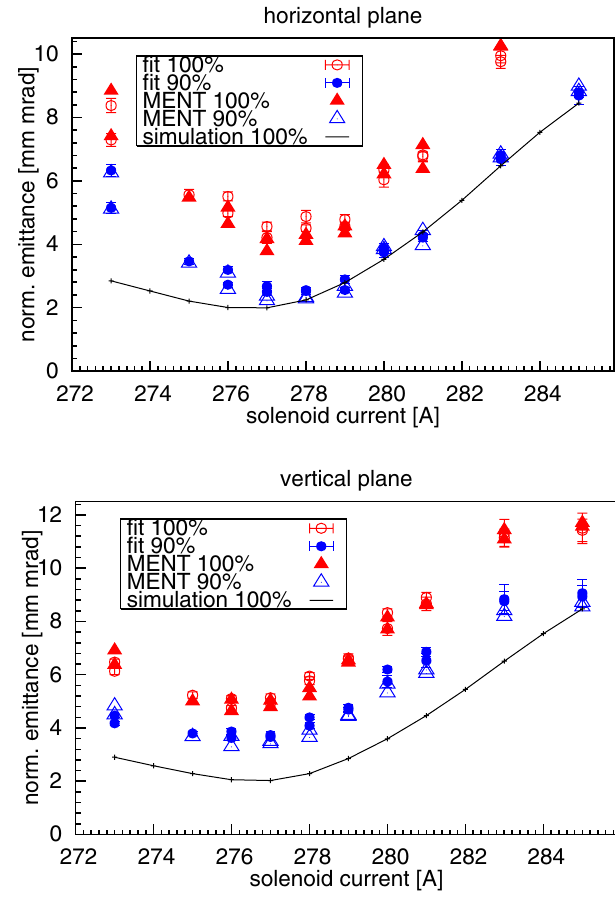
FIG. 6. (Color) Horizontal (top) and vertical (bottom) normal- ized rms emittance measured as a function of the solenoid current. Results obtained by fitting for 100% (red circle) and 90% (blue circle) beam intensity as well as by tomography (MENT) for 100% (red triangle) and 90% (blue triangle) inten- sity are shown. Error is the statistical error only. The solid line is not a fit but a prediction from simulations assuming the design emittance of 2 mm mrad.